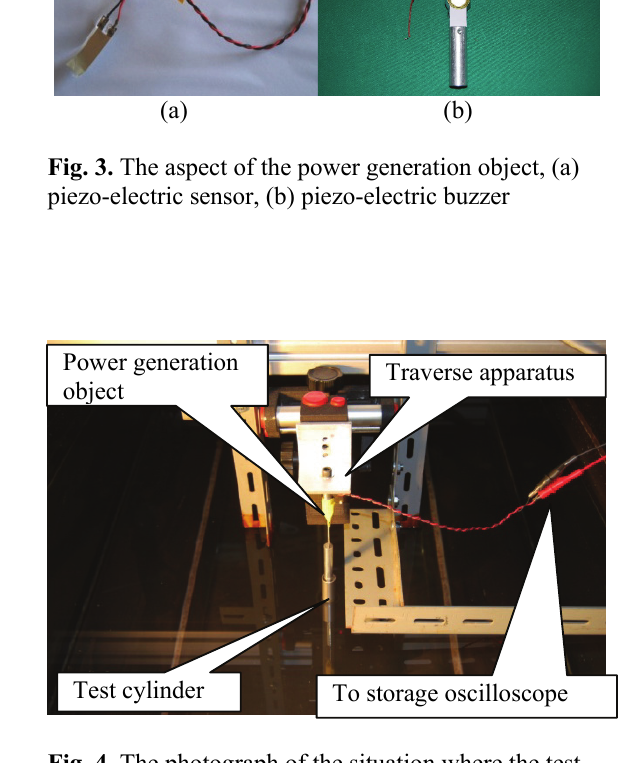
Fig. 4. The photograph of the situation where the test cylinder was set in the traverse